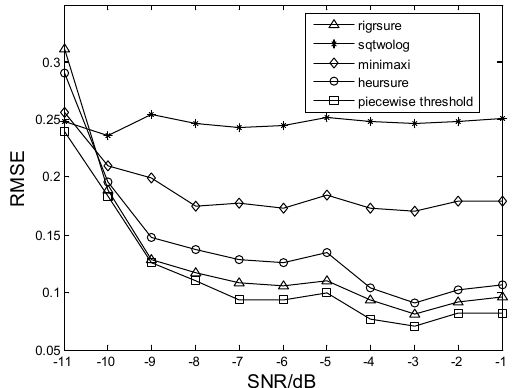
Fig. 4 Comparison of different threshold criteria